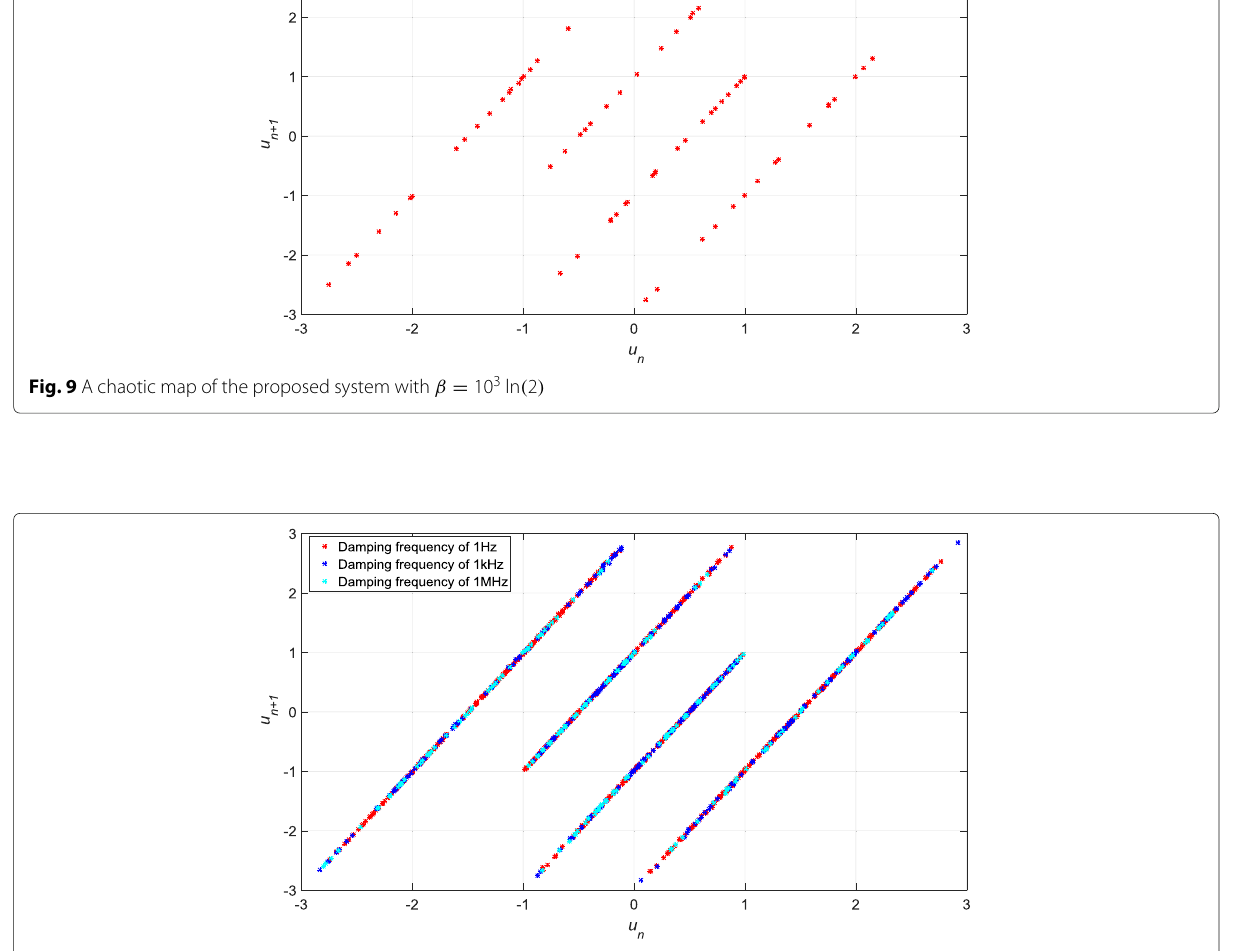
Fig. 10 A chaotic map of the proposed system with variable damping frequencies